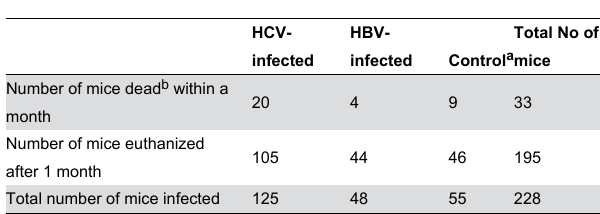
Table 1. Total number of MUP-uPA/SCID/Bg mice engrafted and infected with either HCV or HBV and survival rate.